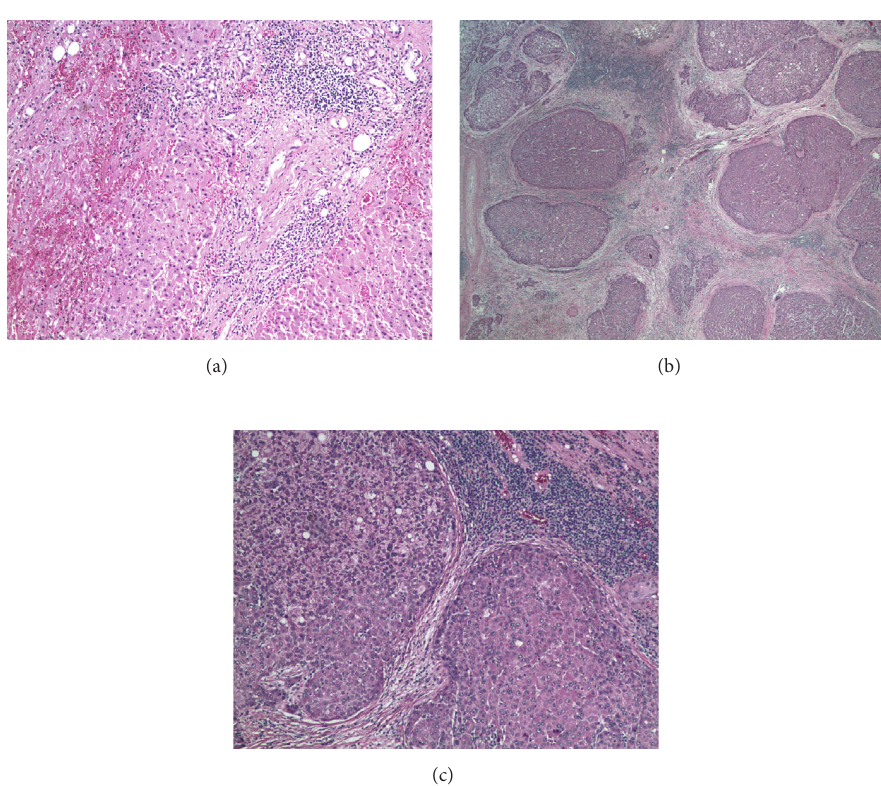
Figure 4: (a) H & E section (40x) shows the background normal liver cells showing mild to moderate portal triaditis and interface hepatitis (grade II) with most portal area infiltrated by many lymphocytes and few plasma cells as typical for hepatitis C. There is mild to moderate septal fibrosis that appears to be periportal and portal-portal (stage II). (b) H & E section (10x) shows multinodular hepatocellular carcinoma with fibrosis around the individual nodules. (c) H & E section (40x) shows poorly differentiated nature of the hepatocellular carcinoma with surrounding significant lymphocytic